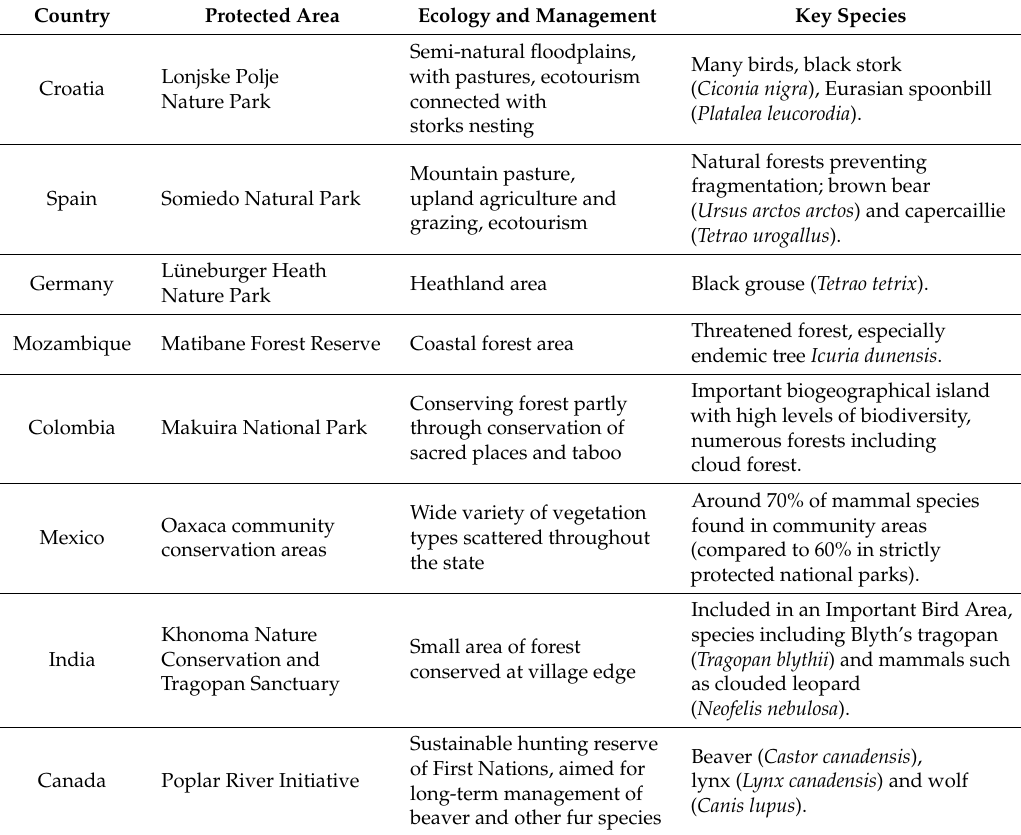
Table 2. Examples of protected landscapes and seascapes conserving wild biodiversity. Source: Dudley and Stolton, 2012